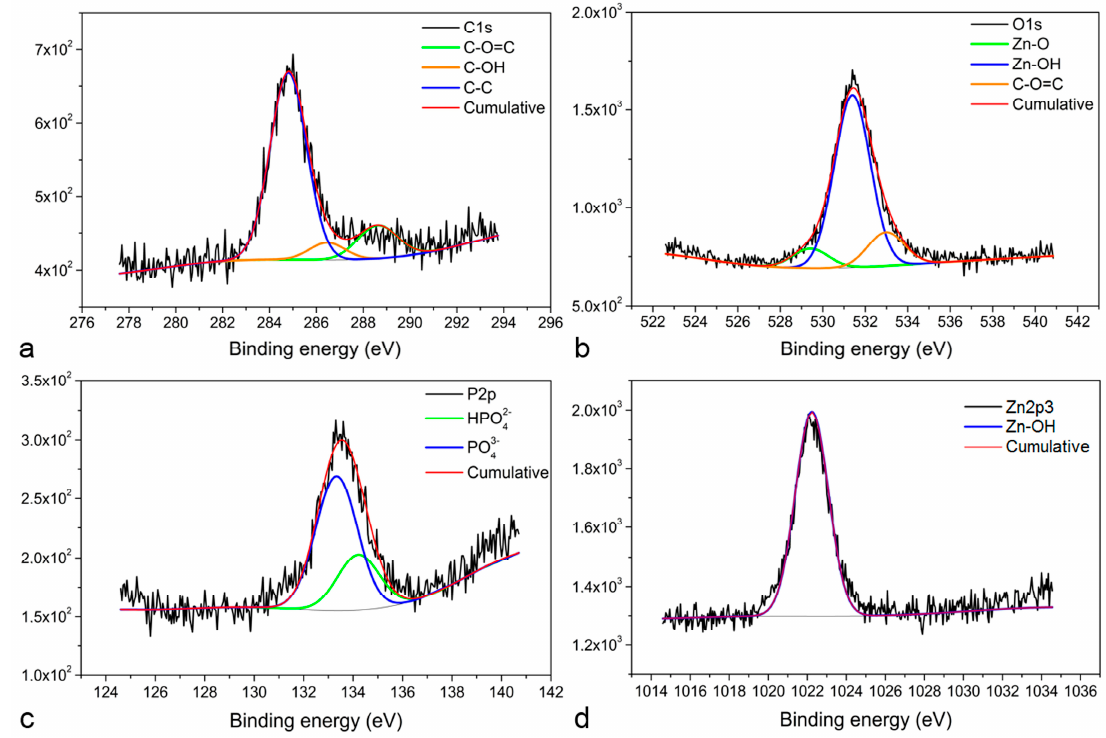
Figure 4. High resolution XPS spectra for Zn–0.5Al specimen: ( a ) C1s peaks, ( b ) O1s peaks, ( c ) P2p peaks, and ( d ) Zn2p3 peak.